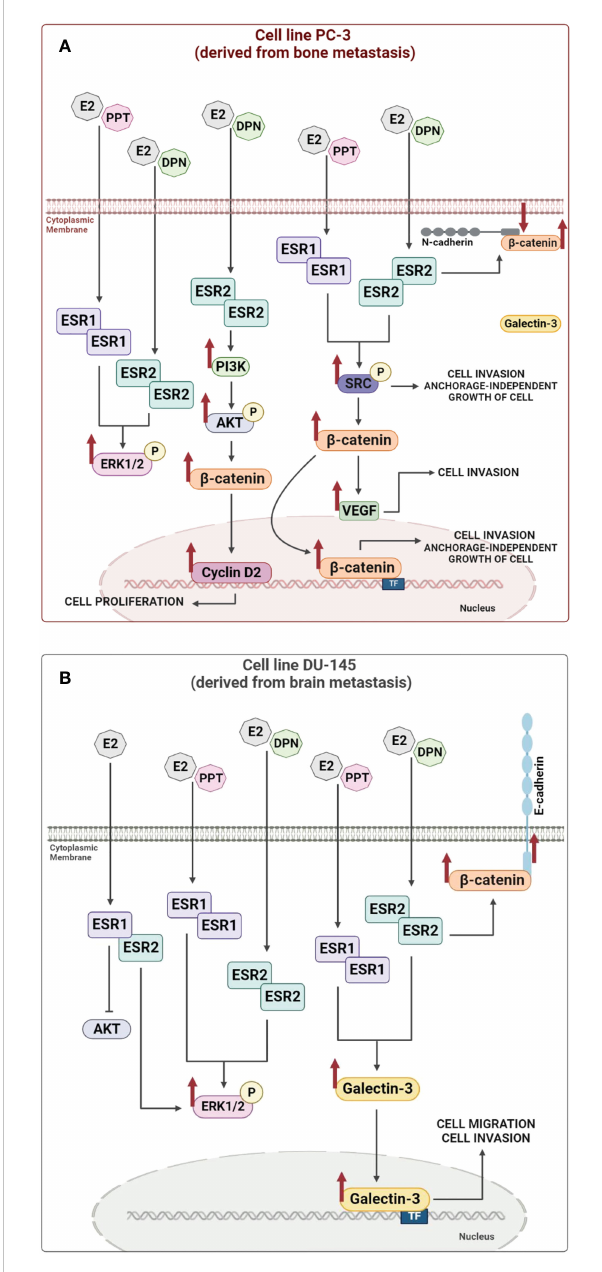
FIGURE 1 Illustration of the molecular regulatory mechanisms responsible for the expression of the non-phosphorylated b -catenin and Galectin-3 induced by estrogen receptor activation. Activation of estrogen receptors ESR1 and ESR2 by E2, PPT or DPN increases (arrows) the phosphorylation of SRC, ERK1/2 or AKT and the expression of non- phosphorylated b -catenin, Cyclin D2, VEGF and Galectin-3, which in turn can modulate nuclear transcriptional events, such as, proliferation, migration, invasion, and anchorage-independent growth of androgen-independent prostate cancer cells PC-3 ( A ) and DU-145 ( B ) (see 54, 67, 68, 73 – 76 for more information). TF (transcription